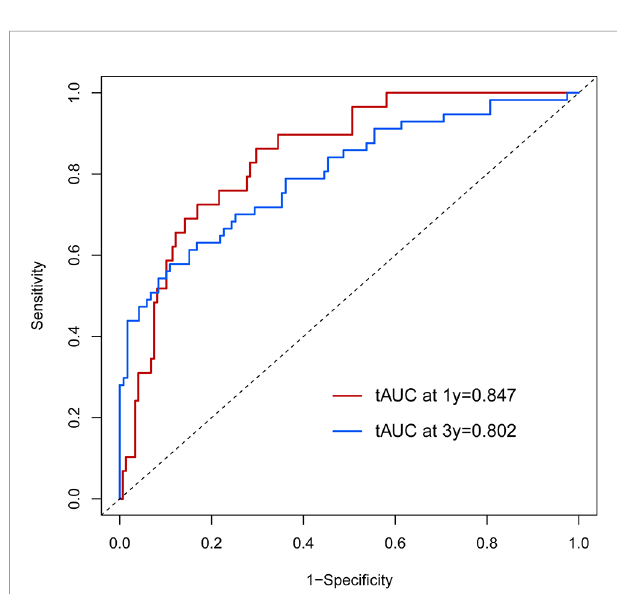
FIGURE 9 | The time-dependent receiver operating characteristic (tdROC) curve of the prognostic nomogram in the external